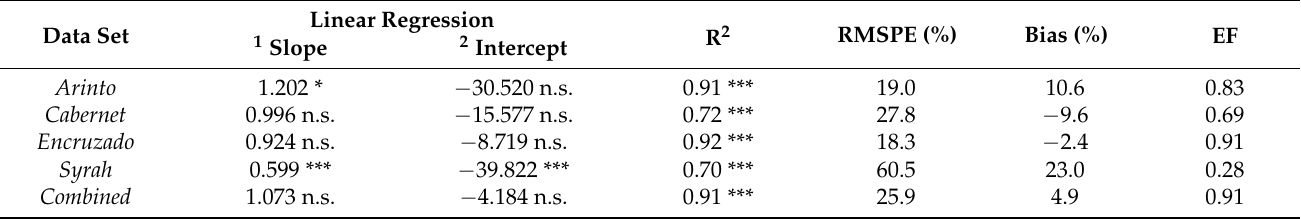
Figure 4. Regression analysis between estimated bunch weight (predictor) and observed bunch weight for the training and test sets. Marker colors: green squares = Arinto ; purple diamonds = Caber- net ; blue circles = Encruzado ; red triangles = Syrah . Table 5. Linear regression models between estimated bunch weight (predictor) and actual bunch weight (response) on the test set, respective statistical measures of validation, and t -test for slope and intercept